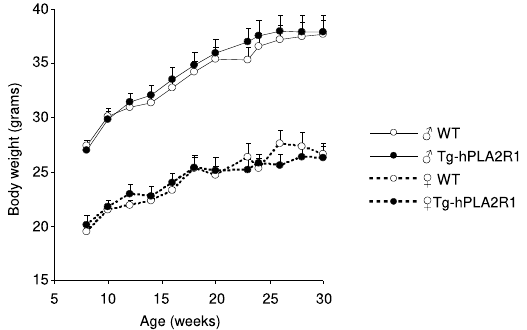
Figure 5. Body weight curves of Tg-hPLA2R1 and WT littermate mice. WT (males n = 10 and females n = 8) and Tg-hPLA2R1 (males n = 8 and females n = 5) animals were weighted every 2–3 weeks from 6 weeks to 30 weeks of age. Curves represented the mean weight ± SEM. Sex and genotype are as